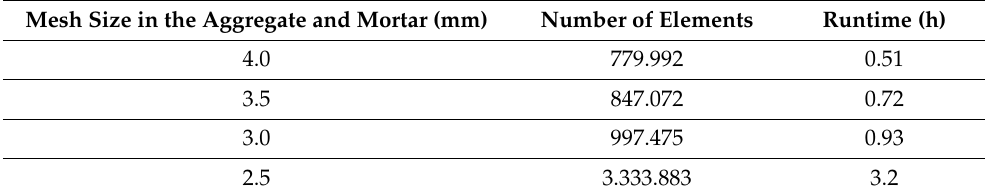
Table 3. Properties of each generated mesh. Mesh Size in the Aggregate and Mortar